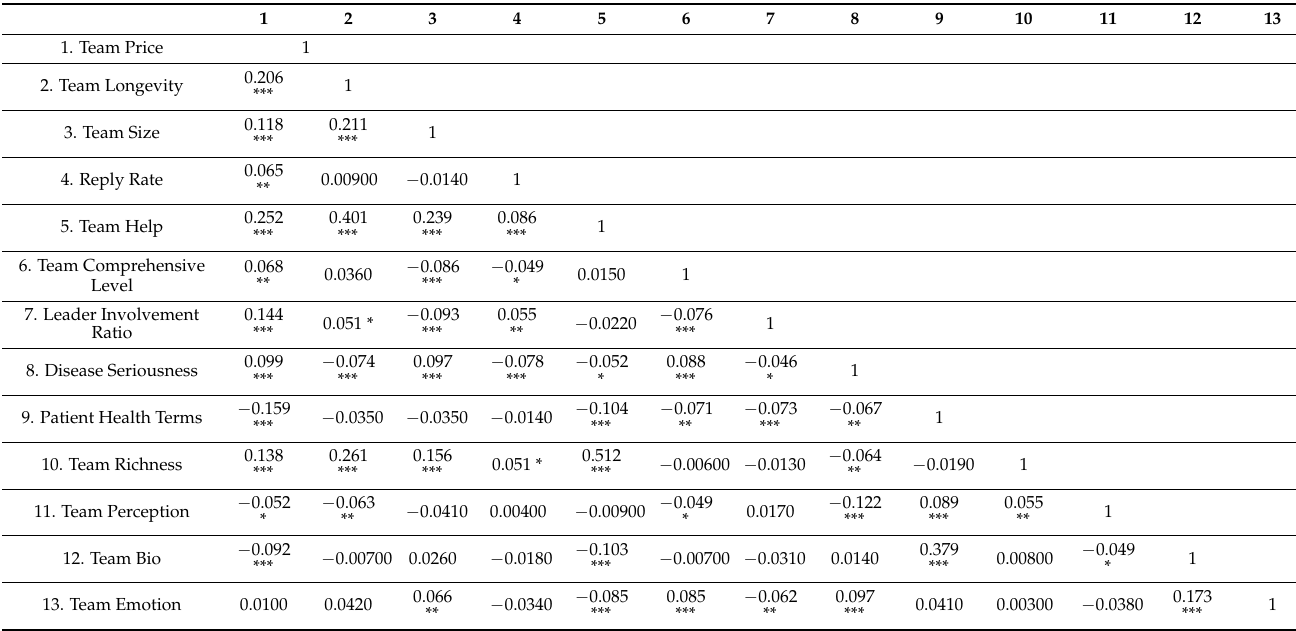
Table 6. Table of the correlation coefficient (n =